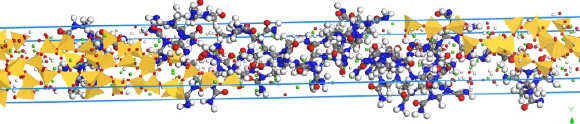
Figure 8. Snapshot of model stretch (Color legend: hydrogen H (white); calcium Ca (green); oxygen O (red); silica Si (yellow polyhedra); nitrogen N (blue) carbon C (grey)).